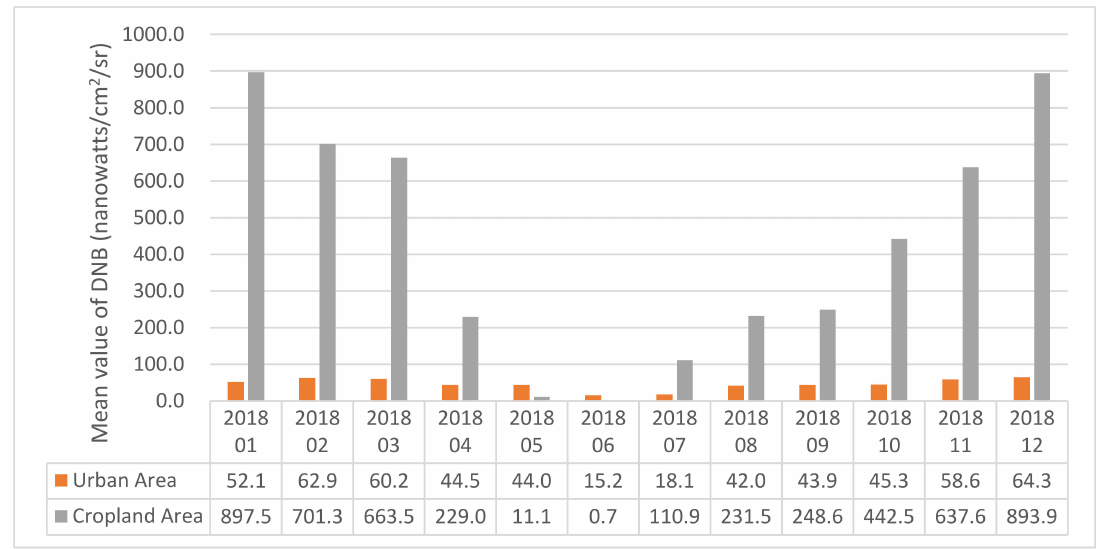
Figure 16. Mean values of DNB in two typical areas from January to December